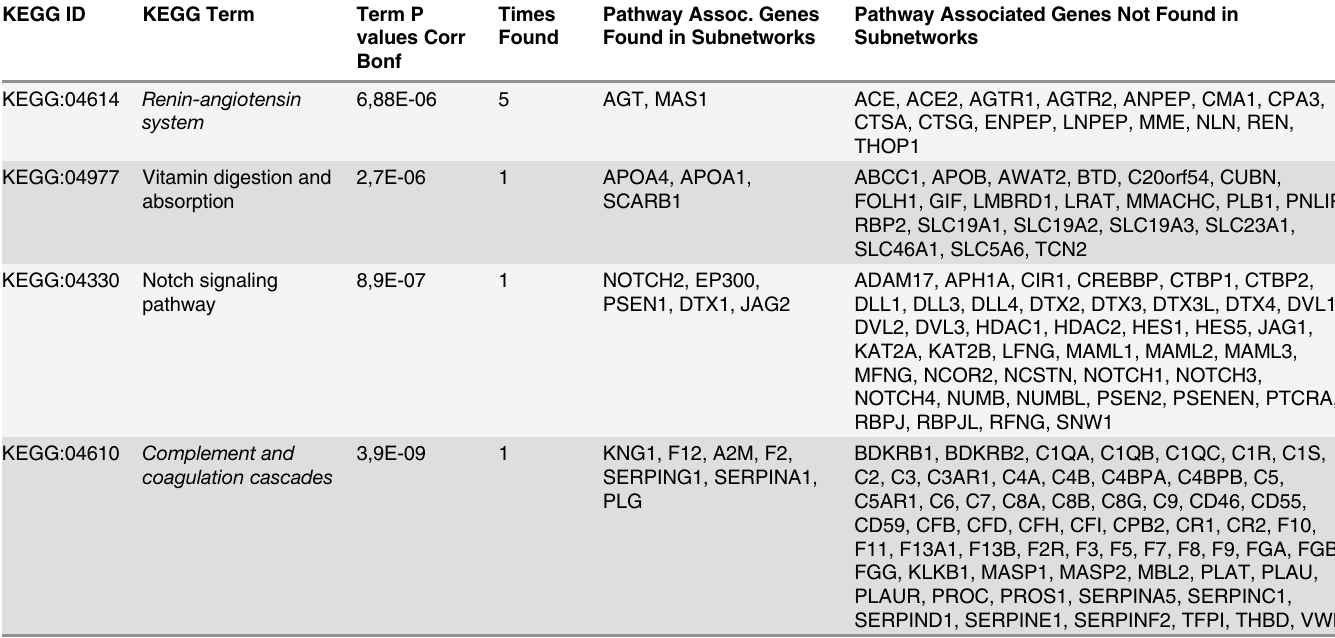
Table 4. Molecular pathways and associated proteins in PMS subtype.